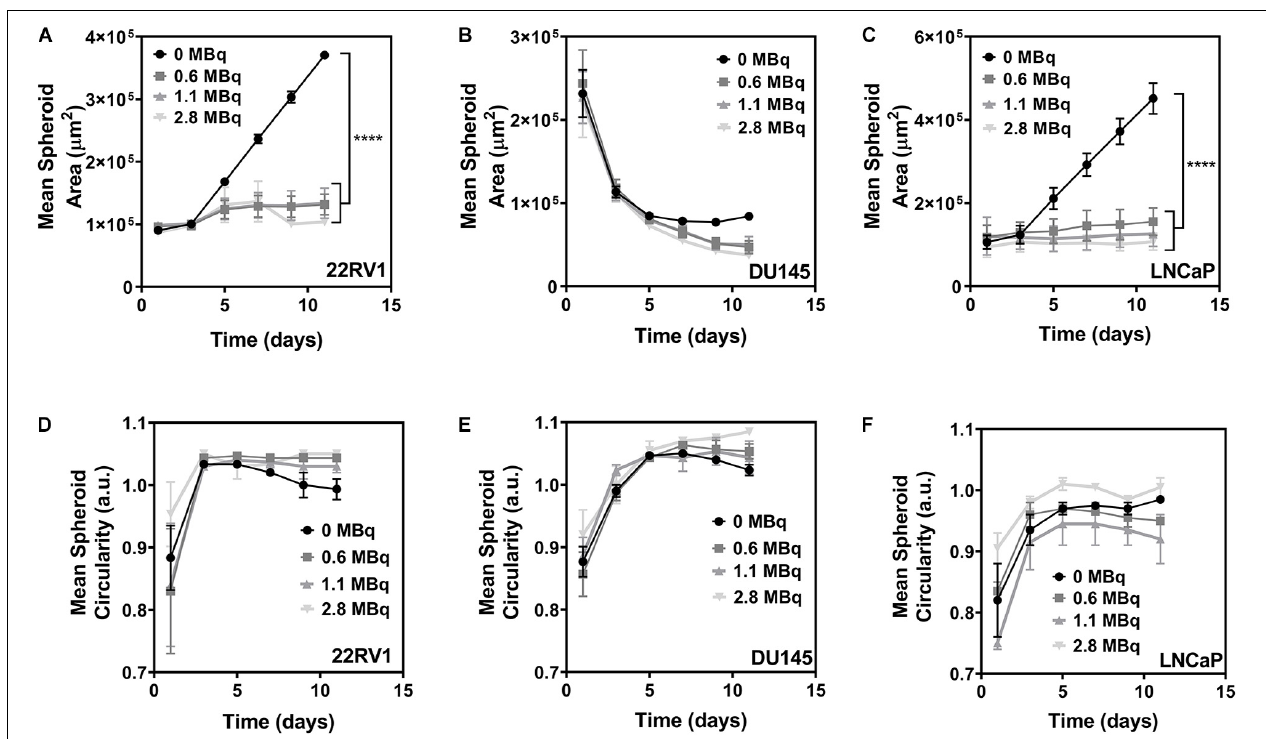
FIGURE 4 | Effects of the exposure to 64 CuCl 2 on 3-day old PCa spheroids. (A–C) Growth curves represented by the mean area (in µ m 2 ) of 22RV1, DU145 and LNCaP spheroids, respectively, as a function of the number of days in culture. (D–F) Mean circularity of 22RV1, DU145 and LNCaP spheroids, respectively, represented as a function of the number of days in culture. Data are presented as the average ± S.E.M. of 3 independent assays. **** p <